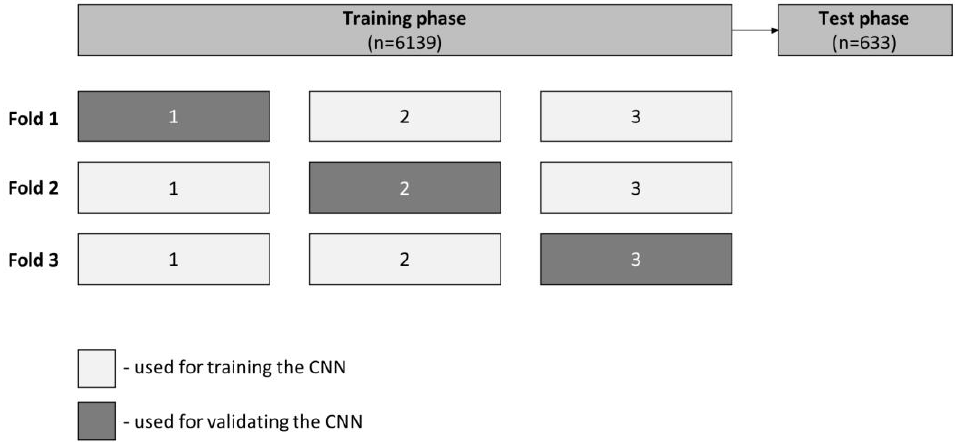
Figure 3. Schematic representation of three-fold cross-validation performed during the training phase. Frames were randomly divided into three equal groups from the total training set. We used two of the three created groups (66.7%) for training and one (33.3%) for model validation. We ran three runs with the aforementioned proportions but varying the groups used for training and validation. The remaining 10% of the data set was used to test CNN performance independently, during the validation phase.